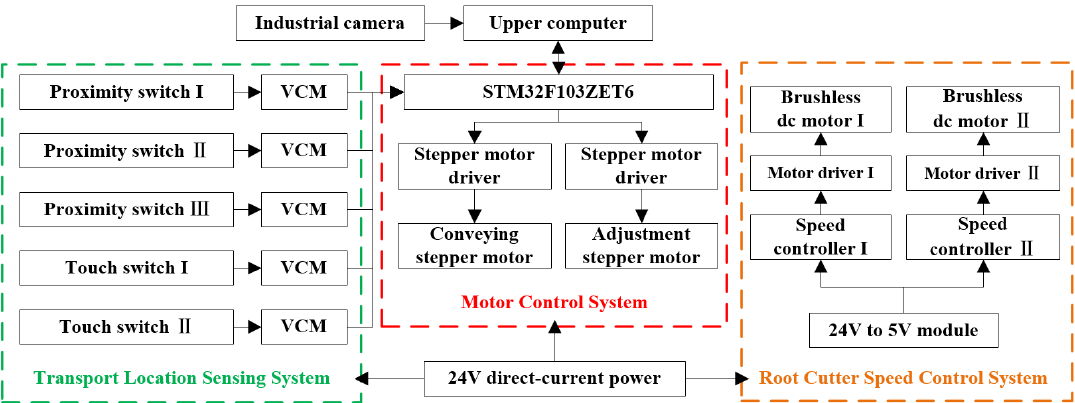
Figure 3. Hardware block diagram of the control system.